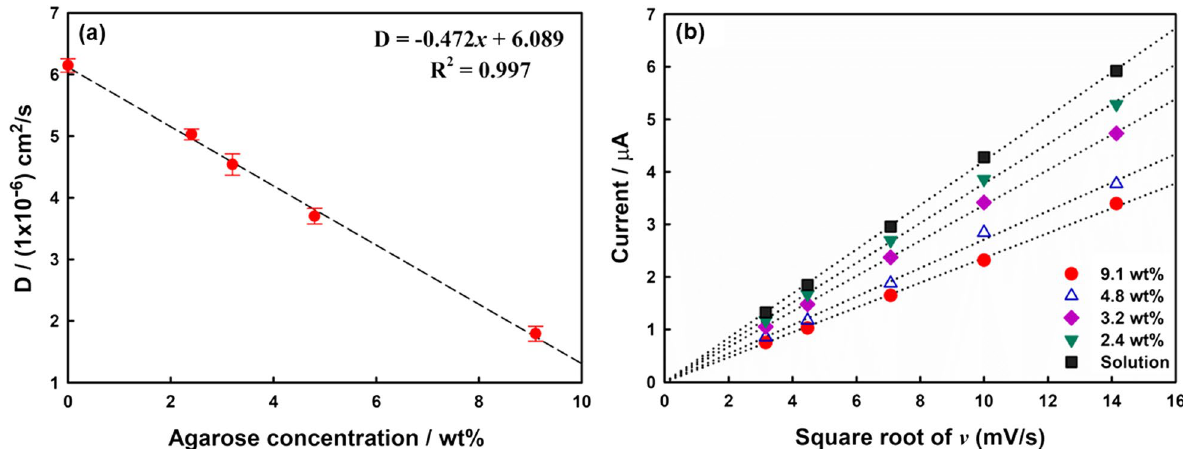
Fig. 2 a D of Fe(CN) 64– as a function of the agarose concentration in the gel. Error bars are obtained based on three independent measurements. b Plots of the anodic peak current as a function of v 1/2 at various agarose